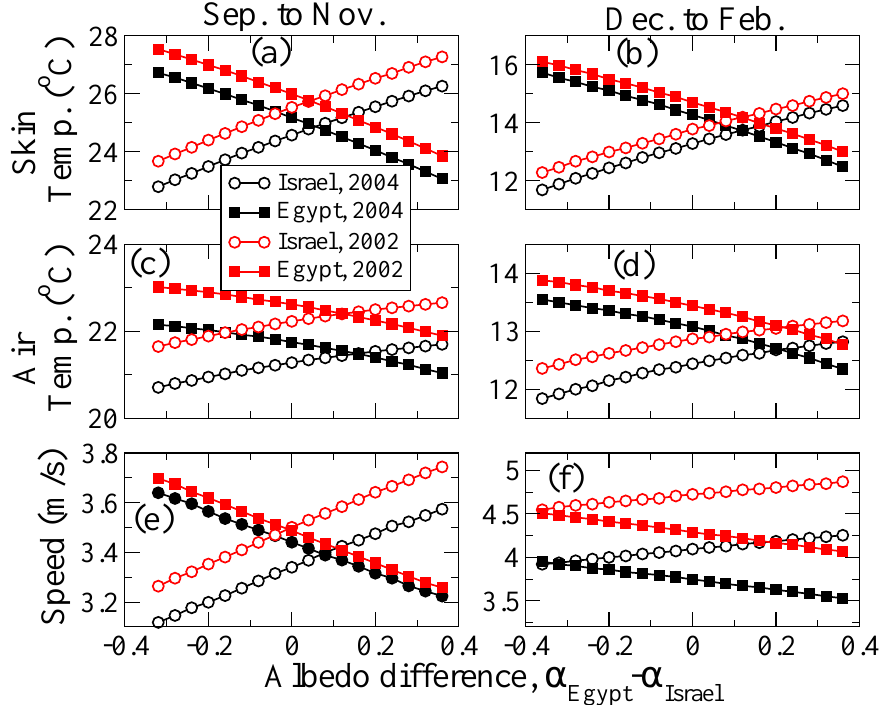
Figure 3. Summary of the WRF simulations averaged spatially on the Egyptian (squares) and Israeli (circles) sides of the inner grid (Figure 1a) and averaged temporally over September to November (left panels) and December to February (right panels) for the years 2002 (red) and 2004 (black). The observed winds were relatively strong during 2002 and relatively weak during 2004. ( a , b ) Skin (ground) temperature; ( c , d ) Surface air (2 m height) temperature; and ( e , f ) 10 m wind speed as a function of the albedo difference between the Egyptian and Israeli sides. Note the almost linear relation in almost all curves, indicating a higher temperature and increased wind activity on the vegetated side.